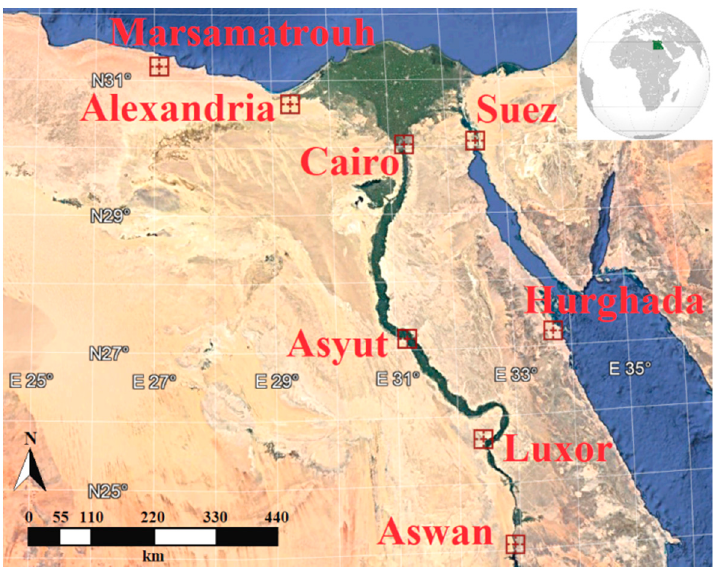
Figure 3. Study region and the specific locations of ALE, CAI, SUE, HUR, ASW, LUX, MAR and ASY. In CAI, ASY and ASW a financial analysis was additionally performed.